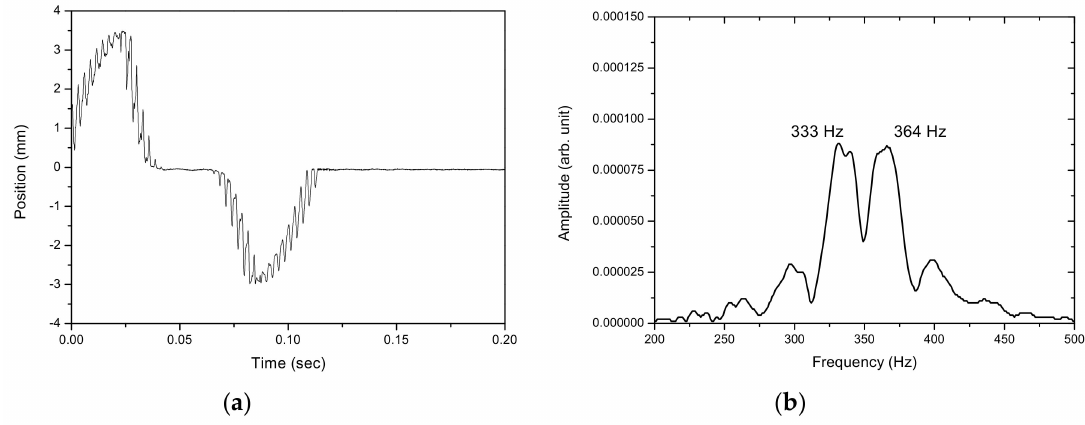
Figure 16. ( a ) The PSD-detected signal and ( b ) the frequency spectrum of the motion of the vibrating string at 6.8 × 10 − 2 m/s.